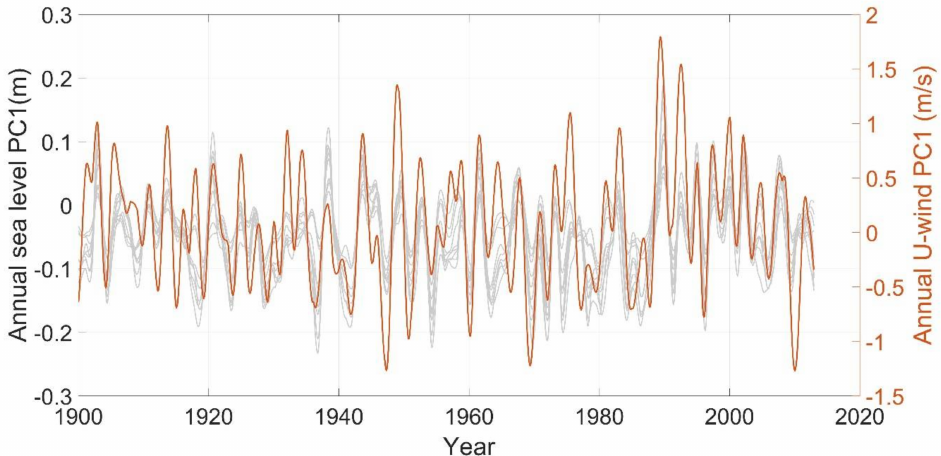
Figure 14. CSEOF first mode PC time series of sea level (cm) at nine tide gauges (Table 2) in 1900–2012. The PC time series of zonal wind (m/s) is overlaid.